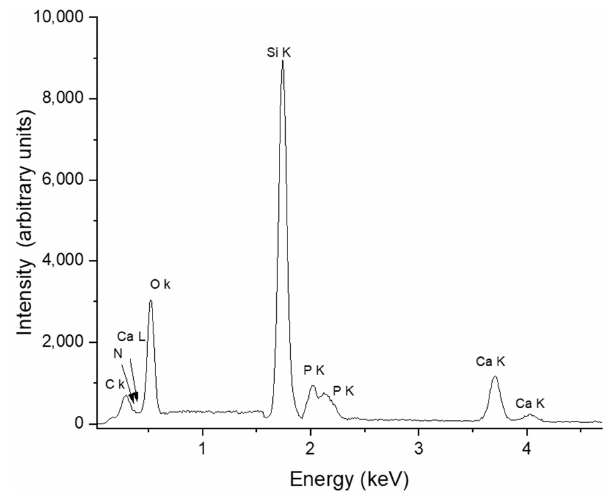
Figure 7. EDS spectrum of HApCs layers generated at 5 × 10 −3 mbarr Ar gas working pressure.